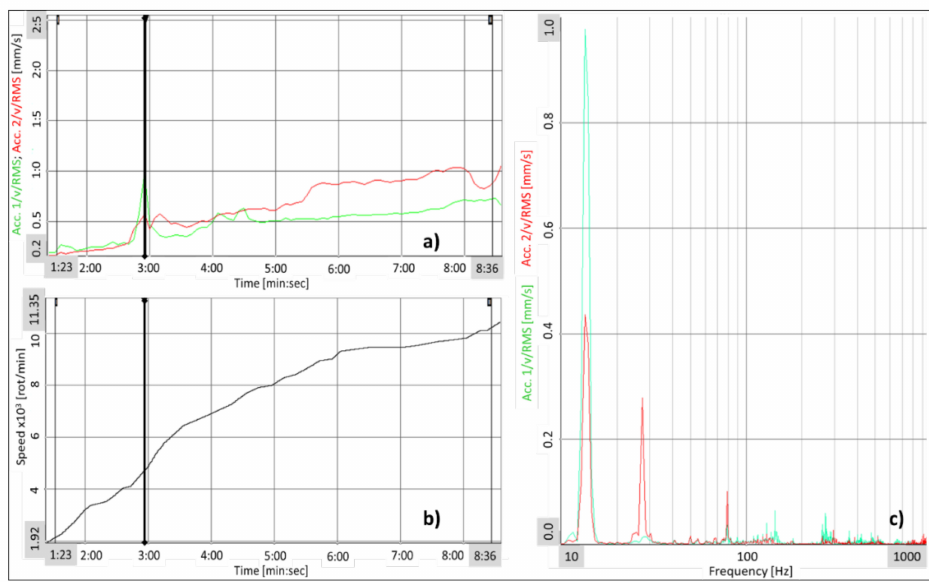
Figure 22. ( a ) Vibration level variation over time; ( b ) Speed variation over time; ( c ) Spectral analysis of speed (4400 rot/min) corresponding to cursor location from ( a ) and ( b ).